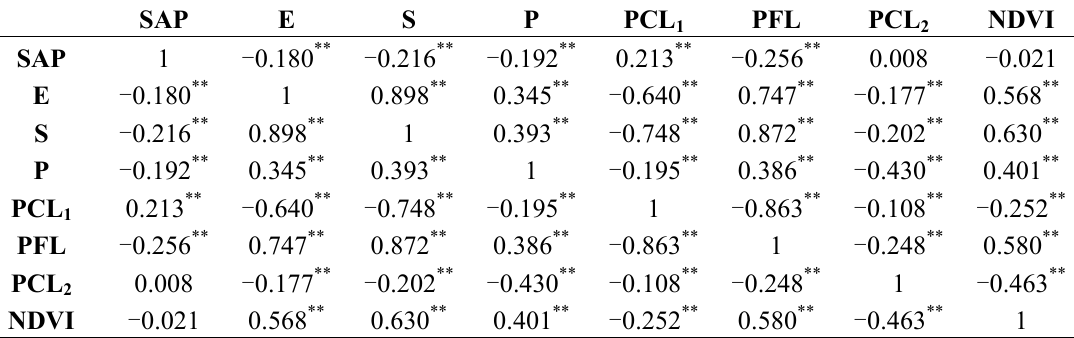
Table 9. Correlation coefficient of subwatershed scale soil available phosphorus content and environmental